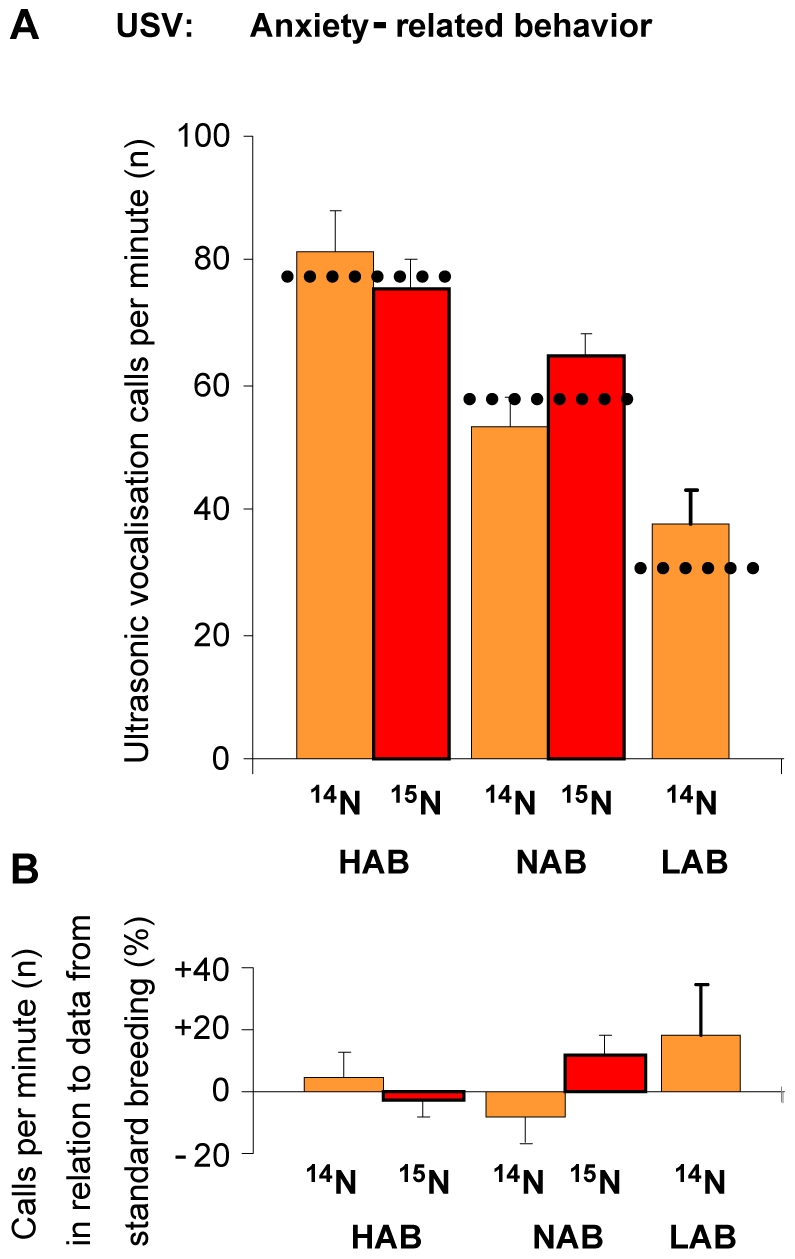
(A) Anxiety-related behavior at post natal day 5 in the ultrasonic vocalization test (USV).High (HAB), normal (NAB) and low (LAB) anxious animals were fed with 14N or 15N enriched bacteria diets. A) Independent of the diet, HAB, NAB and LAB mice showed the significant (not indicated) phenotypic divergence typical of animals of the standard breeding (dotted lines and indicated in B) as percentage difference of the standard breeding).